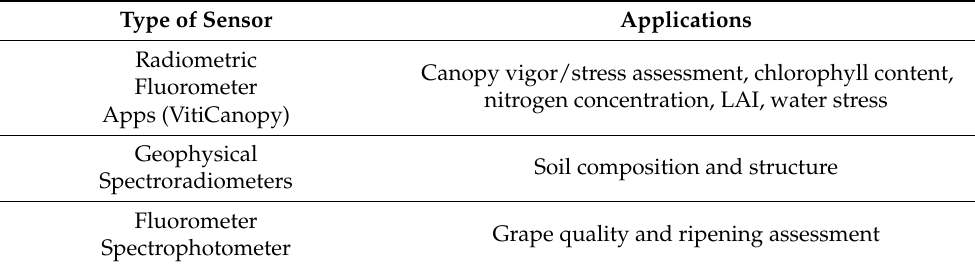
Table 5. Proximal sensing sensors and relative